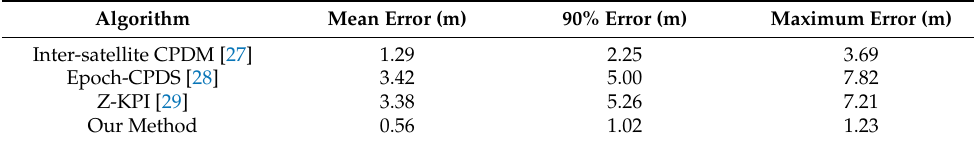
Table 3. Comparison and analysis of positioning accuracy of various methods.